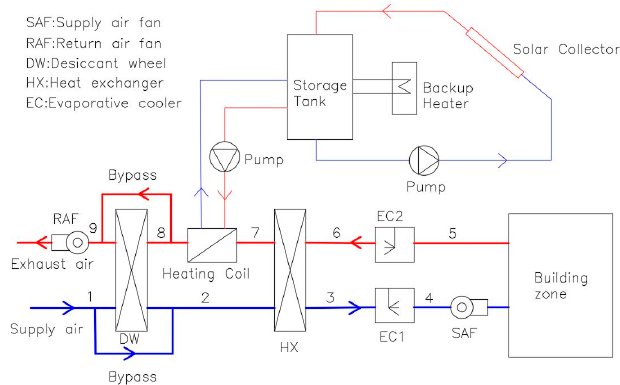
Figure 6. Schematic diagram of the SDEC system [55].